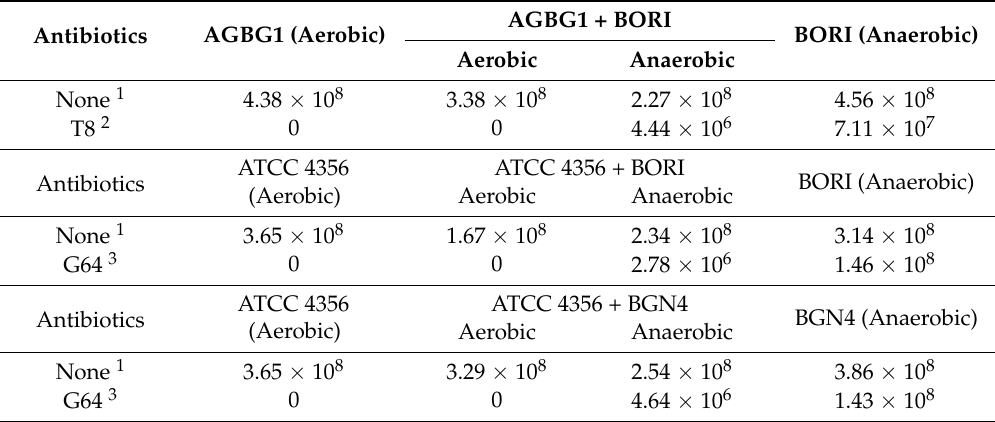
Table 4. Transferability of tetracycline resistance from donors ( B. longum BORI and B. bifidum BGN4)